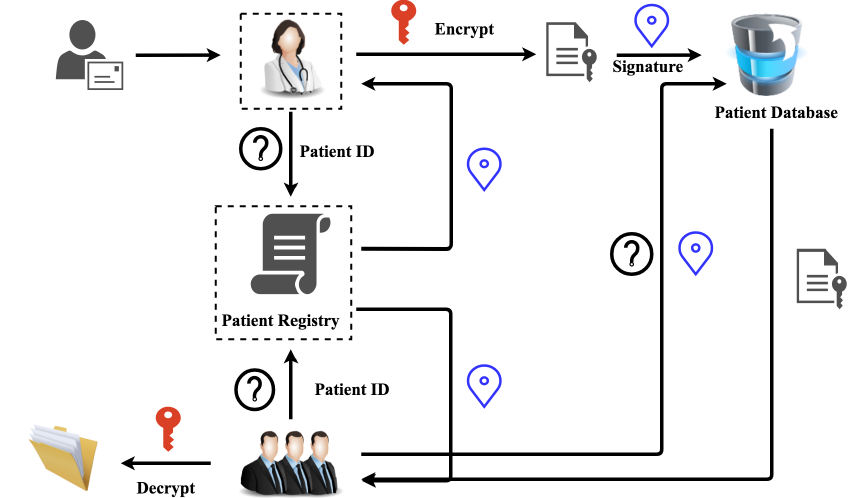
Figure 8. Blockchain-based healthcare application workflow